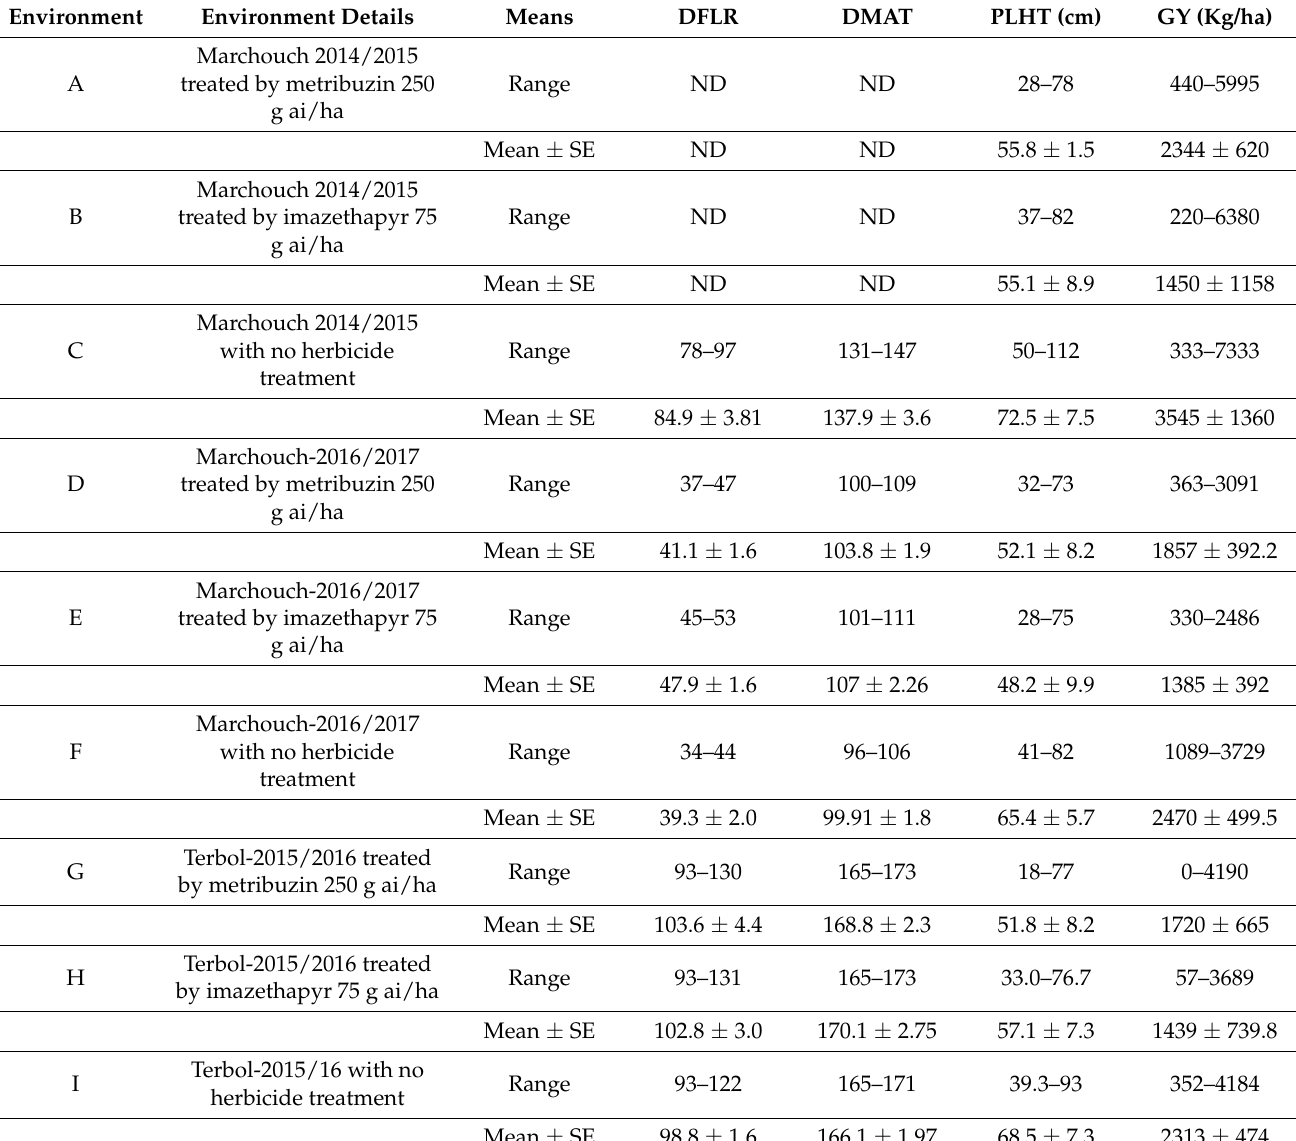
Table 2. Means ± Standard error (SE) and ranges for different traits in the different